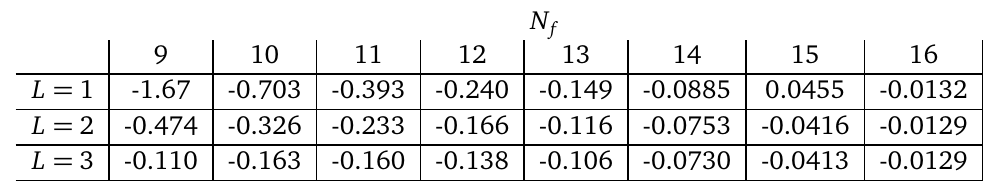
Table 5: Anomalous dimension γ ∗ serting the L + 1 loop critical coupling α ∗